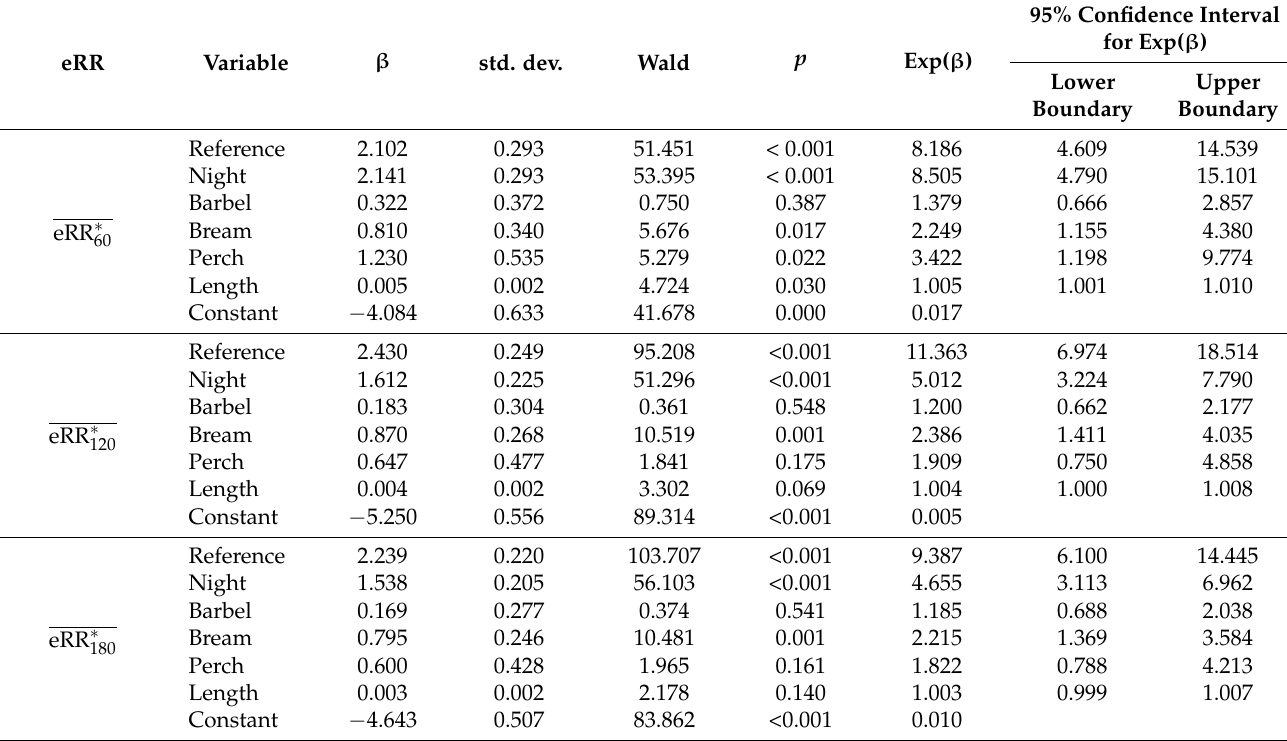
Table 6. Results of the binary regression analysis for the three evaluation durations of one, two and three hours (eRR ∗ , eRR ∗ and eRR ∗ ) based on the number of stocked fish with exclusion of initial 60 120 180 effects. Regression coefficient β , standard deviation (std. dev.), Wald statistic (Wald), error probability p , Odds ratio (Exp( β )) and lower and upper boundaries of the 95% confidence interval for Exp( β ).